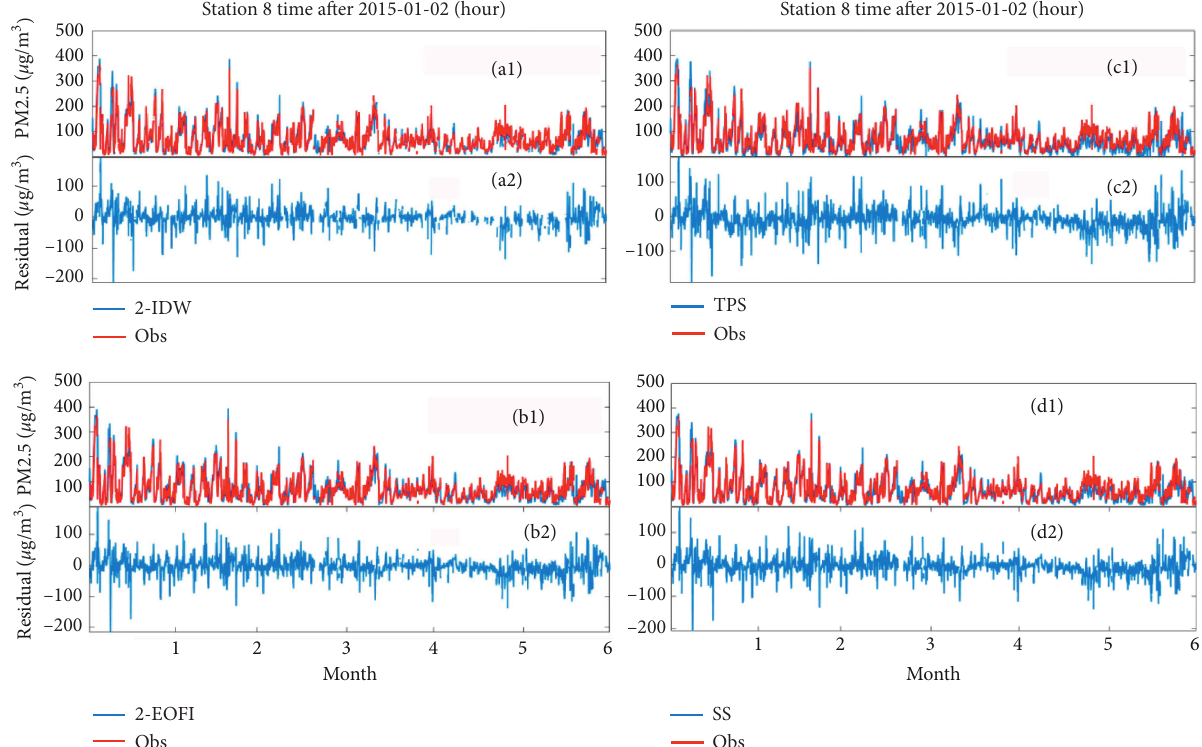
Figure 5: Same as Figure 4, but the IDW and EOFI use P � 2 for sta